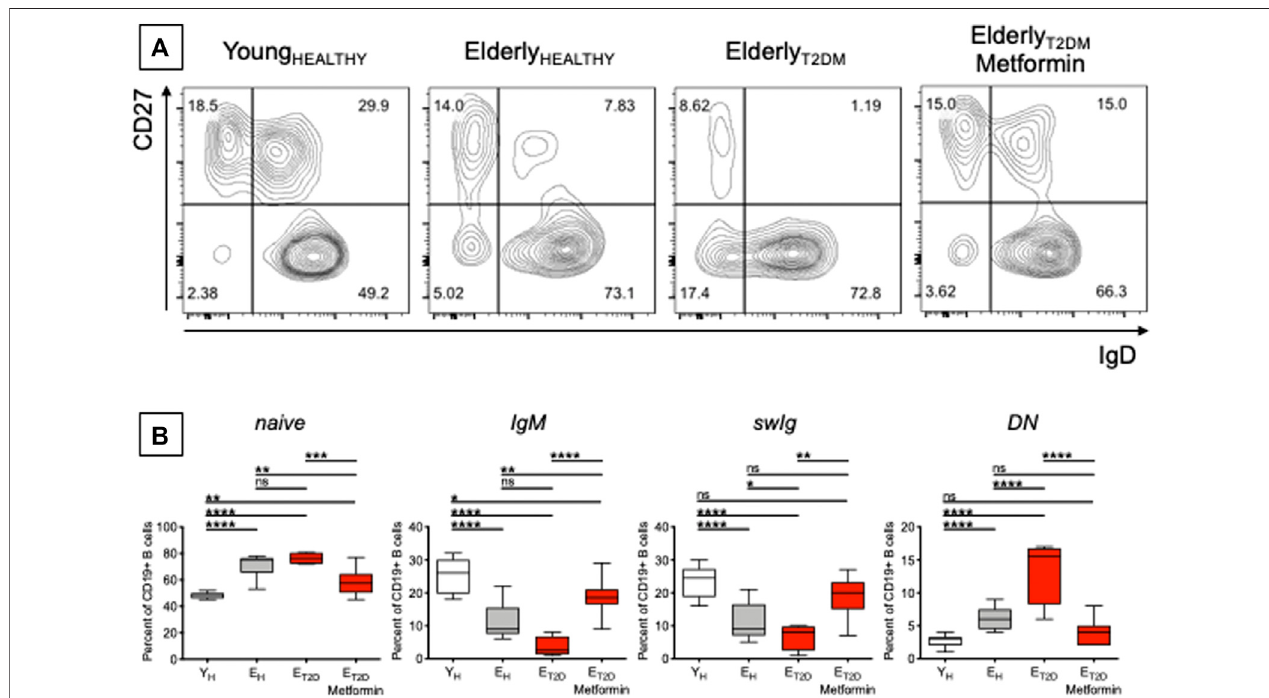
FIGURE 2 | Metformin decreases the frequencies of pro-in fl ammatory B cell subsets in the blood of E T2DM patients. (A) Gating strategies and a representative contour plot from one individual/group. In this representative plot, naïve (IgD + CD27 − ) are in the lower right quadrant, IgG memory (IgD + CD27+) are in the upper right quadrant, swIg (IgD-CD27+) are in the upper left quadrant and DN (IgD-CD27-) are in the lower left quadrant. (B) Frequencies of the 4 B cell subsets in the 4 groups of individuals. Mean comparisons between groups were performed by one-way ANOVA. * p < 0.05, ** p < 0.01, *** p < 0.001, **** p < 0.0001.